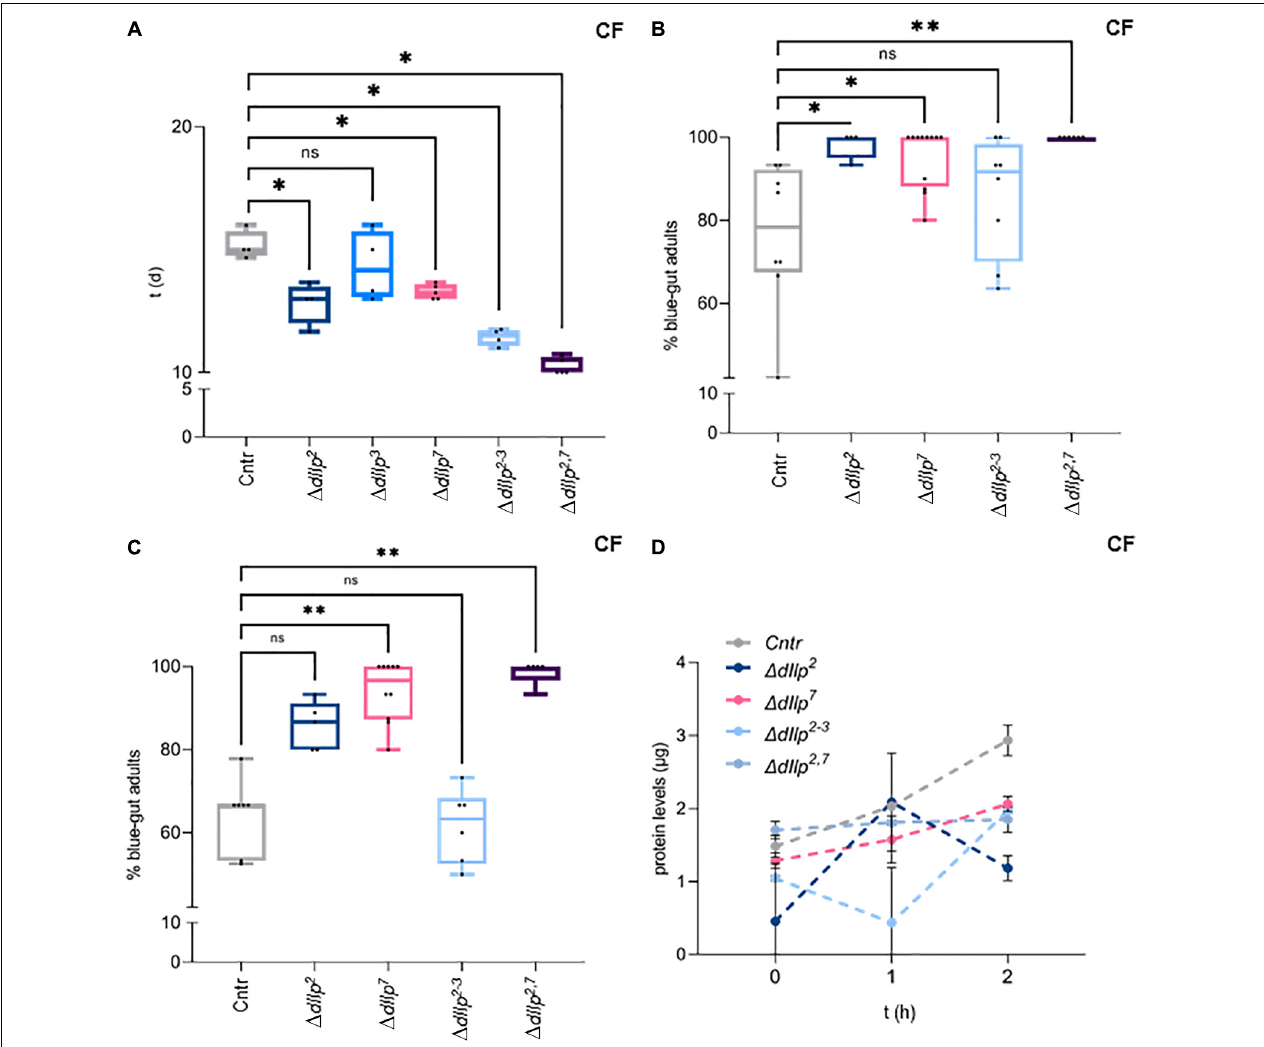
FIGURE 3 | DIlp7 regulates food intake, transition and absorption of adult flies kept on yeast-free food. (A) Shown are box-plots depicting survival rates of staged adult flies transferred onto yeast-free corn food (CF) at 25 ◦ C. Plotted is time (in days, d) to reach 50% lethality for genetic controls ( mCherry:FOXO , Cntr) and different dIlp mutants as indicated. One black dot = one experiment. Significance calculated by Mann-Whitney’s test, Cntr vs. (cid:49) dIlp 2 , (cid:49) dIlp 2 − 3 : p = 0.0286 ∗ ; Cntr vs. (cid:49) dIlp 3 : p = 0.5714 ns ; Cntr vs. (cid:49) dIlp 7 , (cid:49) dIlp 2 , 7 : p = 0.0159 ∗ . For crude data, see Supporting informations_Raw data_Main figures/ Supplementary Figure 3A . (B,C) Plotted are the percentage of adult females kept on dye-containing corn food (CF) with colored abdomens after 4 h (B) , and colored-abdomen flies transferred onto dye-less corn food (CF) with colored abdomens after 4 h (C) at 20 ◦ C. The data for genetic controls ( mCherry:FOXO , Cntr) and different dIlp mutants are depicted as box plots; one black dot = one experiment. (B) Significance calculated by Kruskal-Wallis test, Cntr vs. (cid:49) dIlp 2 : p = 0.0282 ∗ ; Cntr vs. (cid:49) dIlp 7 : p = 0.0132 ∗ ; Cntr vs. (cid:49) dIlp 2 − 3 : p > 0.9999 ns ; Cntr vs. (cid:49) dIlp 2 , 7 : p = 0.013 ∗∗ . For crude data, see Supporting informations_Raw data_Main figures/ Supplementary Figure 3B . (C) Significance calculated by Kruskal-Wallis test, Cntr vs. (cid:49) dIlp 2 : p = 0.2396 ns ; Cntr vs. (cid:49) dIlp 7 : p = 0.0016 ∗∗ ; Cntr vs. (cid:49) dIlp 2 − 3 : p > 0.9999 ns ; Cntr vs. (cid:49) dIlp 2 , 7 : p = 0.0012 ∗∗ . For crude data, see Supporting informations_Raw data_Main figures/ Supplementary Figure 3C . (D) Starved flies were transferred onto plates loaded with protein baits at 20 ◦ C and hemolymph was taken after set time intervals (in hours, h; 0, 1, and 2 h). Plotted are measured hemolymph protein levels of genetic controls ( mCherry:FOXO , Cntr) and different dIlp mutants as indicated. Error bars represent standard deviation; plotted are the mean. Significances calculated by Dunnett’s multiple comparison test but not shown to avoid overloaded graph, 0 h: Cntr vs. (cid:49) dIlp 2 : p = 0.072 ∗∗ ; Cntr vs. (cid:49) dIlp 7 : p = 0.9132 ns ; Cntr vs. (cid:49) dIlp 2 − 3 : p = 0.4179 ns ; Cntr vs. (cid:49) dIlp 2 , 7 : p = 0.8744 ns . 1 h: Cntr vs. (cid:49) dIlp 2 : p = 0.9990 ns ; Cntr vs. (cid:49) dIlp 7 : p = 0.4465 ns; Cntr vs. (cid:49) dIlp 2 − 3 : p = 0.0002 ∗∗∗ ; Cntr vs. (cid:49) dIlp 2 , 7 : p = 0.8939 ns . 2 h: Cntr vs. (cid:49) dIlp 2 : p < 0.0001 ∗∗∗∗ ; Cntr vs. (cid:49) dIlp 7 : p = 0.0260 ∗ ; Cntr vs. (cid:49) dIlp 2 − 3 : p = 0.0285 ∗ ; Cntr vs. (cid:49) dIlp 2 , 7 : p = 0.047 ∗∗ . For crude data, see Supporting informations_Raw data_Main figures/ Supplementary Figure 3D